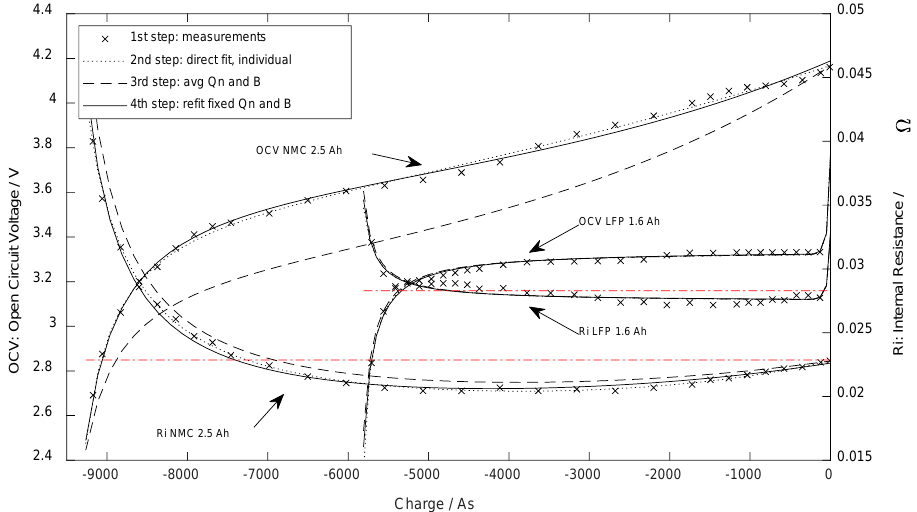
Figure 3. Open-circuit voltage and internal DC resistance at 25 °C dependent on the extracted charge.